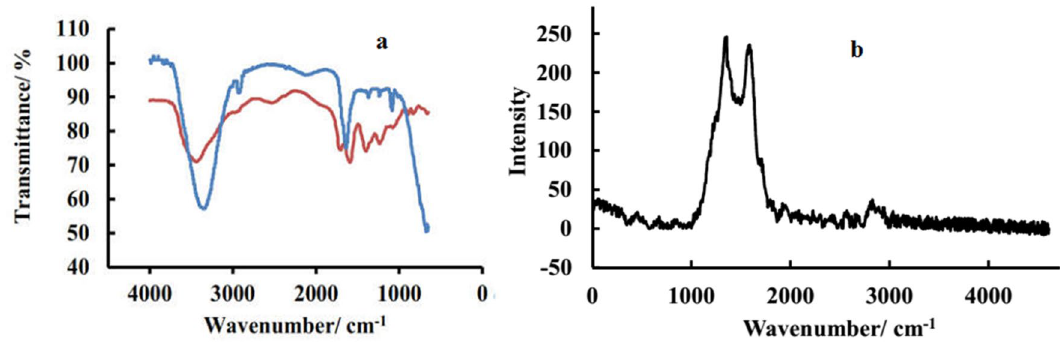
Figure 2. ( a ) FT-IR spectra of (red) GQD and (blue) N, S-GQD; ( b ) Raman spectrum of N,